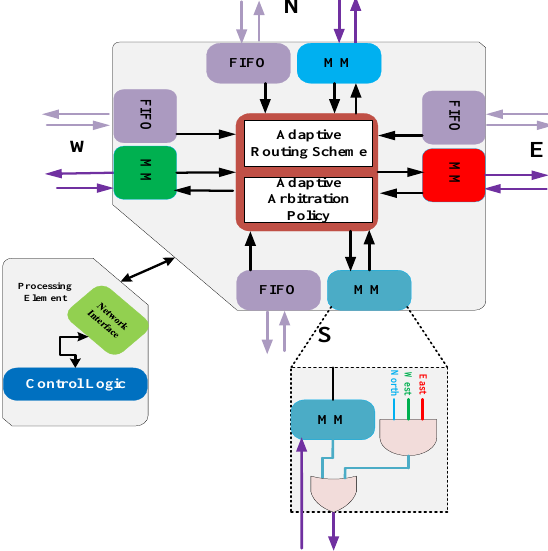
Figure 5. Modified EMBRACE router architecture. FIFO: First in, first out; MM: Monitor module.